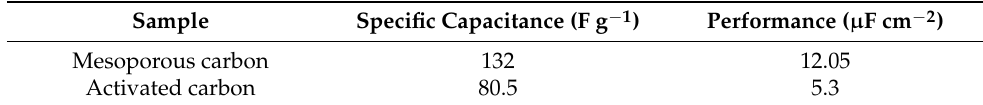
Table 3. The specific capacitance and performance of mesoporous carbons and activated carbon.